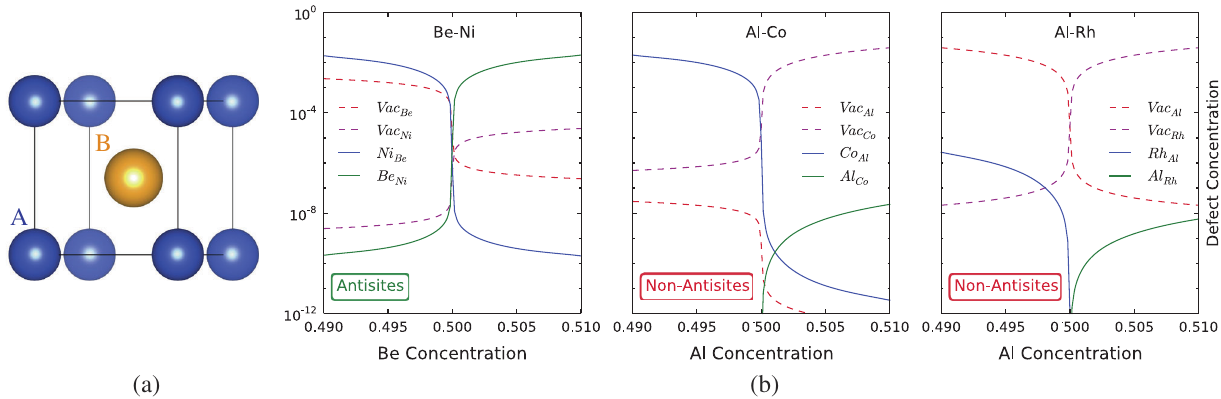
Fig. 1 a Illustration of B2 crystal structure and b the possible dominant defect con fi gurations in B2 intermetallic compounds. BeNi is classi fi ed as antisite dominant intermetallic, whereas AlCo and AlRh are considered as non-antisite dominant